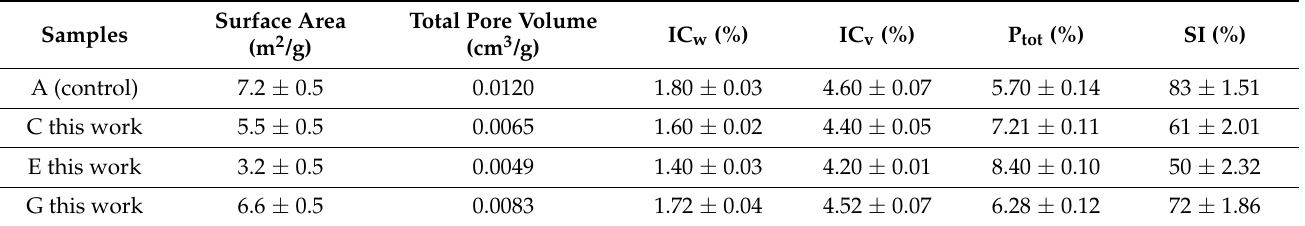
Table 6. Textural features of Pietraforte sandstone and Adsorption coefficient, before and after treatments.